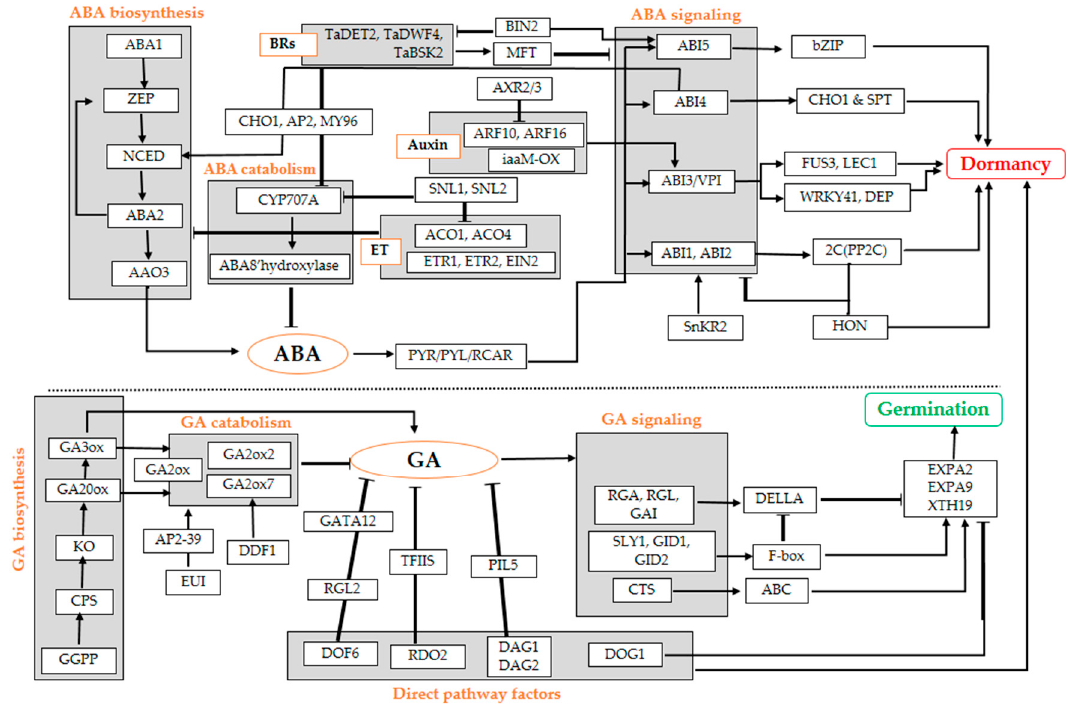
Figure 2. Mechanisms underlining seed dormancy and seed germination control in plants. This figure highlights abscisic and gibberellic acid metabolism and signalling pathways in plants and how ABA-GA balance is affected by the activity of other plant hormones and other genes enabling seed dormancy or seed germination. ABA1 , abscisic acid deficient 1; ABA2 , abscisic acid deficient 2; ZEP, zeaxanthin epoxidase; NCED , carotenoid cleavage dioxygenase; AAO3 , abscisic aldehyde oxidase 3; ABA, abscisic acid; PYR/PYL/RCAR, pyrabactin resistance/pyrabactin-like/regulatory components of ABA receptors; ABI , abscisic acid insensitive; VP1 , viviparous 1; bZIP, basic leucine zipper; CHO1 , CHOTTO 1; SPT , SPATULA; FUS3 , FUSCA3; LEC1 , leafy cotyledon 1; WRKY41, WRKY DNA-binding protein 41; DEP, DESPIERTO; PP2C, protein phosphatase 2C; HON , HONSU; SnRK2, SNF1-related protein kinase 2; CYP707A , Cytochrome P450; ABA8 ′ OH, ABA 8-hydroxylase; AP2 , AP2-domain; MYB96 , myeloblastosis 96; BRs, brassinosteroids; TaDET2 , Triticum aestivum de-etiolated 2; Ta DWF4 , Triticum aestivum DWF 4; TaBSK2 , Triticum aestivum brassinosteroid signaling kinase 2; BIN2 , brassinosteroid insensitive 2; MFT , mother of FT and TFL1; ARF , auxin-responsive factors; AXR2, auxin resistant 2; AXR3, auxin resistant 3; ACO, 1-aminocyclopropane-1-carboxylic acid oxidase; ET, Ethylene; EIN2 , ethylene insensitive 2; ETR1 , ethylene triple response 1; ETR2 , ethylene triple response 2; SNL1 , SIN3-like 1; SNL2 , SIN3-like 2; GGDP, geranylgeranyl pyrophosphate; CPS , ent-copalyl diphosphate synthetase; KO1 , ENT-kaurene oxidase 1; GA3ox1 , gibberellins 3-oxidase 1; GA20ox3 , gibberellins 20-oxidase 3; GA2ox2 , gibberellins 2-oxidase 2; GA2ox7 , gibberellins 2-oxidase 7; AP2-39 , AP2 domain-containing transcription factor OsAP2-39; EUI , elongated uppermost internode; DDF1 , delayed flowering 1; GA, gibberellins; GATA, GATA proteins; ABC, ATP-binding cassette; DOF6 , DNA binding1 zinc finger 6; DAG1 , DOF affecting germination1; DAG2 , DOF affecting germination2; DDF1 , delayed flowering 1; DELLA, DELLA proteins; F-box, F-box proteins; DOG1 , Delay of Germination 1; RGA , repressor of gibberellin acid; RGL1 , repressor of gibberellin acid like 1; RGL2 , repressor of gibberellin acid like 2; RDO2 , reduced dormancy 2; CTS , comatose; PIL5 , phytochrome interacting factor 3-like 5; TFIIS , transcription factor S-II; SLY1 , sleepy1; GAI , gibberellin acid insensitive; GID1 , gibberellin acid insensitive dwarf1; GID2 , gibberellin acid insensitive dwarf2; EXPA2 , expansin-A2; EXPA9 , expansin-A9; XTH19 , xyloglucan endo-transglycosylase 19.